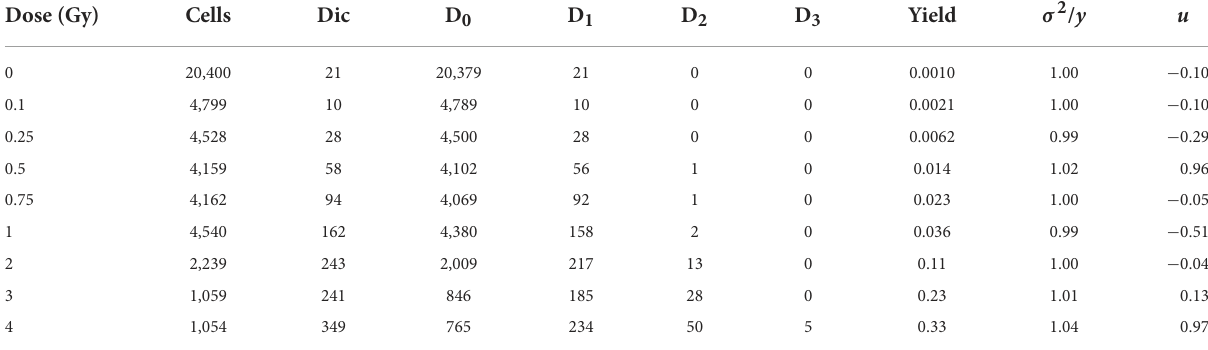
TABLE 1 Number and distribution of dicentrics in human lymphocytes from blood samples irradiated with Co-60 γ -ray.